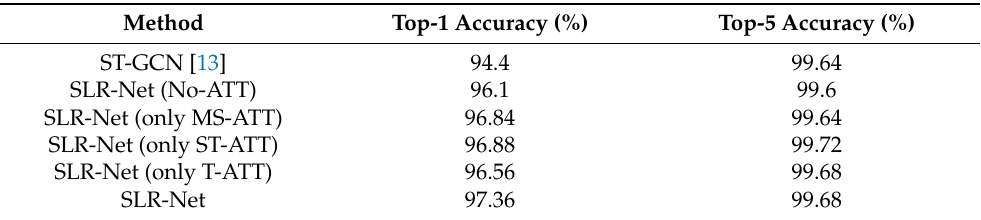
Table 6. Sign languages recognition accuracies by SLR-Net with attention mechanisms, tested on CSL-500 dataset.